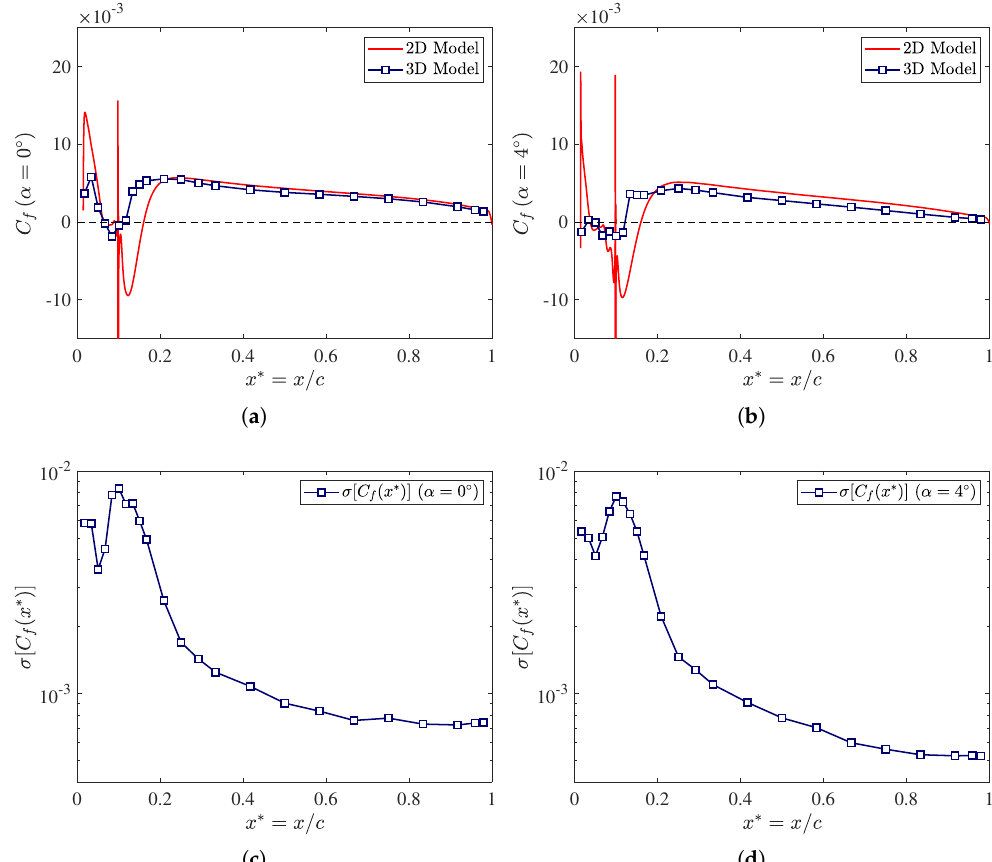
Figure 19. Friction coefficients comparison between the 2D damaged airfoil and the 3D eroded blade. Dark blue squares denote the C f ( x ∗ ) value over the three-dimensional blade. ( a ) C f distribution at 0 ◦ incidence; ( b ) C f distribution at 4 ◦ incidence; ( c ) Friction coefficient standard deviation on the blade at 0 ◦ incidence; ( d ) Friction coefficient standard deviation on the blade at 4 ◦